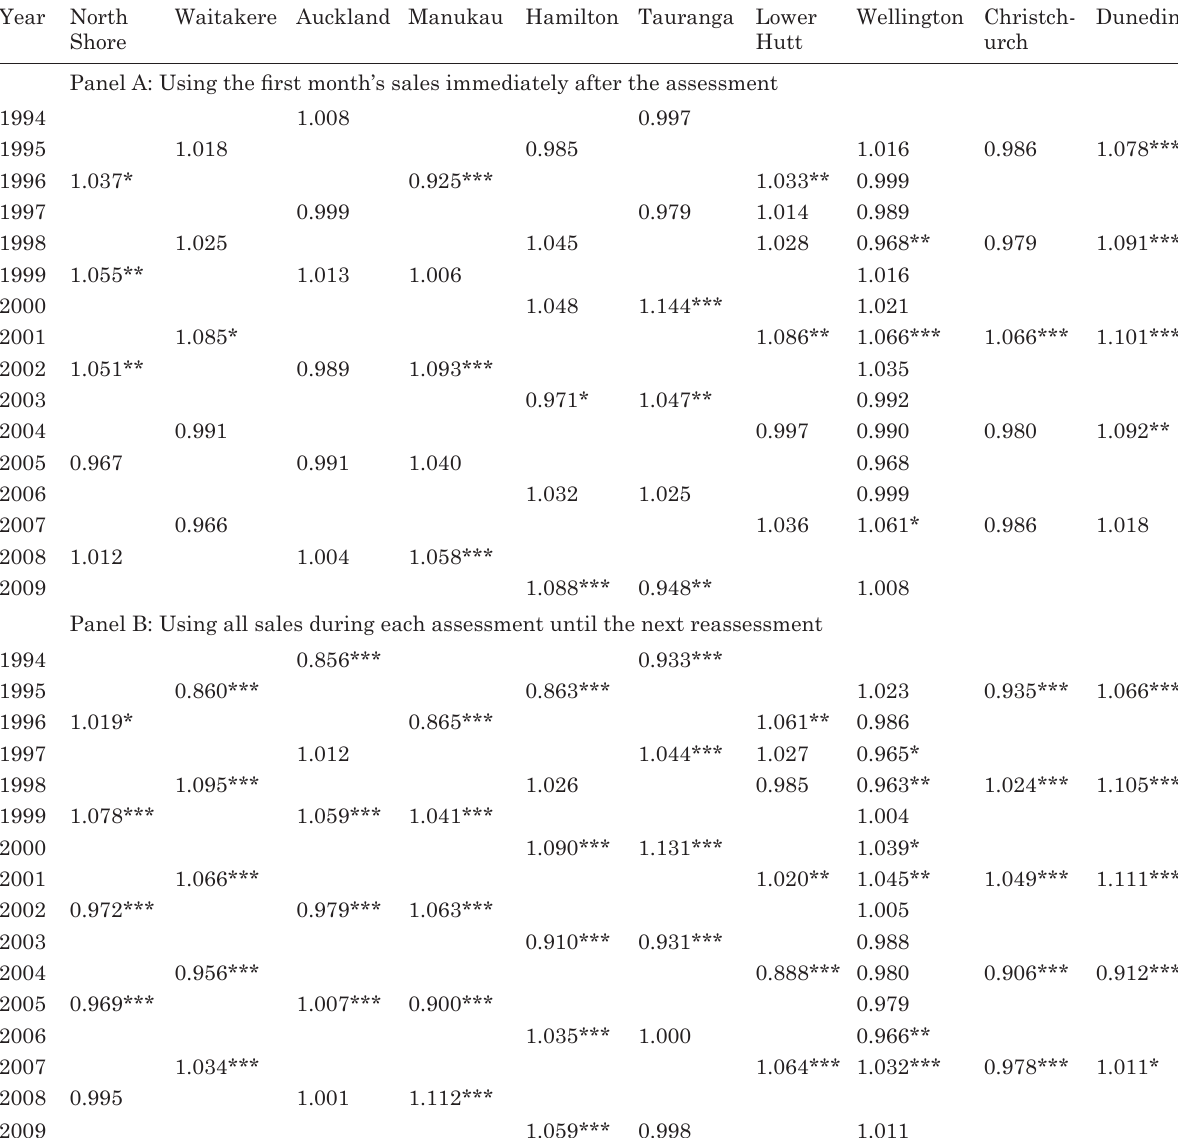
Table 3. Vertical inequities for selected 10 top cities in New Zealand, 1994–2009 Year North Shore Panel A: Using the first month’s sales immediately after the assessment